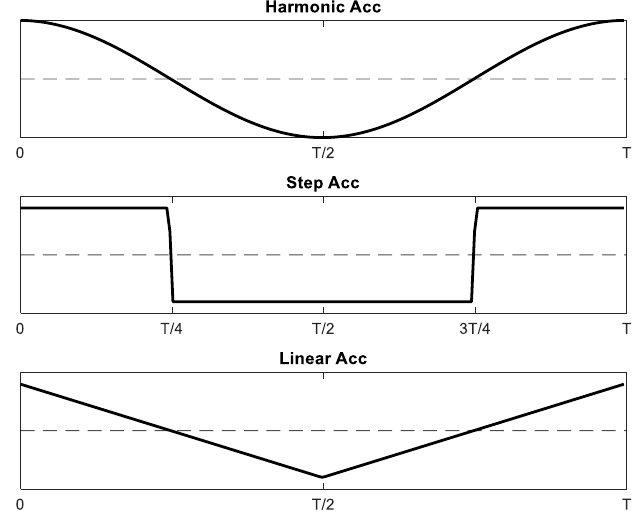
Figure 5. Harmonic, linear, and step acceleration periodic pulses with period T.